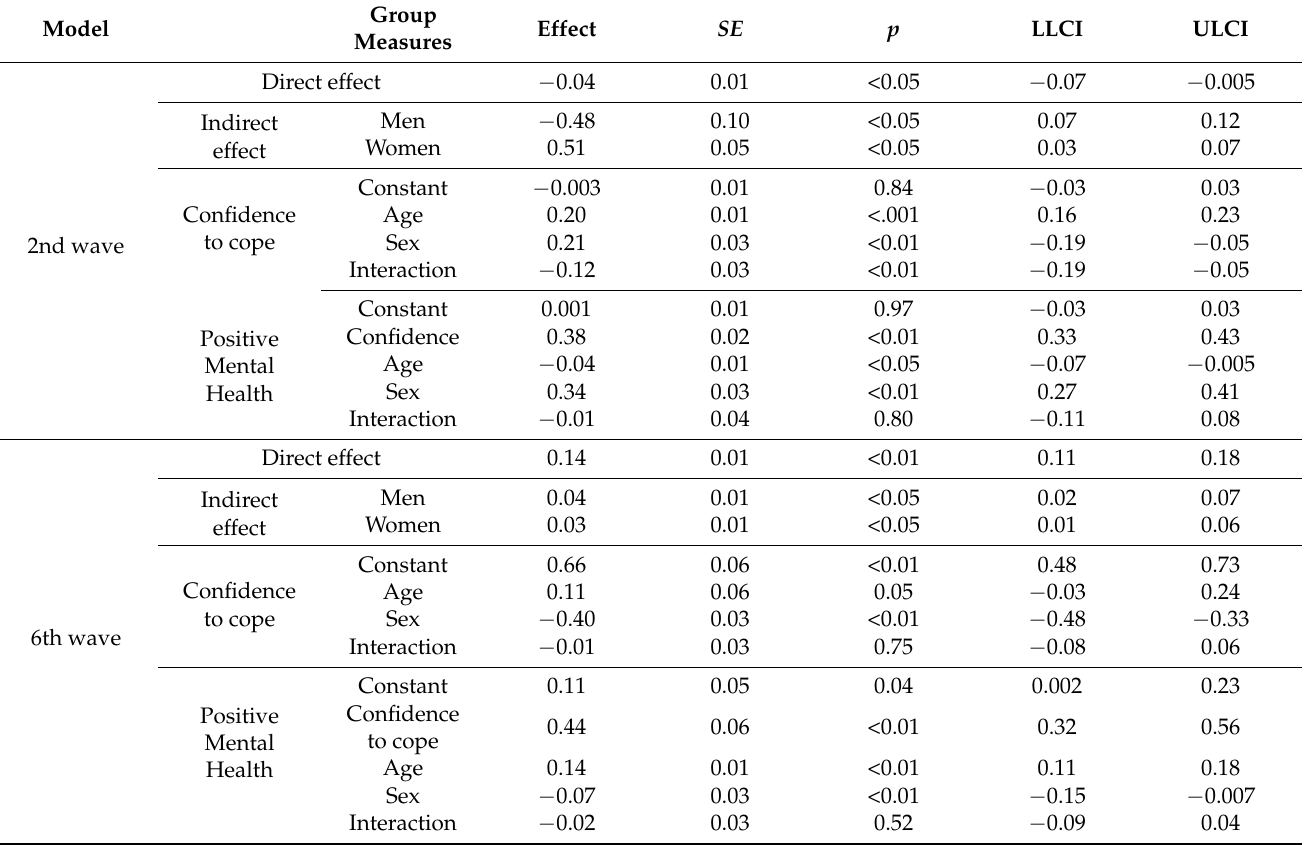
Table 3. Direct and Conditional effect of X on Y at values of the moderator. Effects, standard error (SE), statistical significance and lower and upper (LLCI and ULCI)